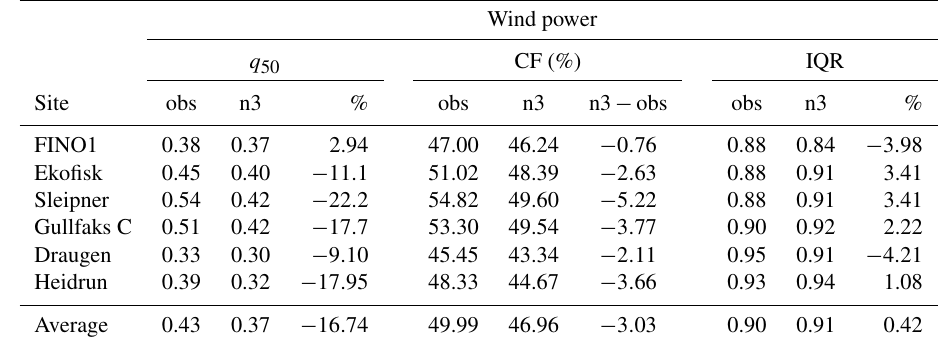
Table 9. Mean absolute ramp rate (MAR P observation-based and model-based estimates of the wind power output. The difference between the modeled and observed MAR P divided by the observed MAR P